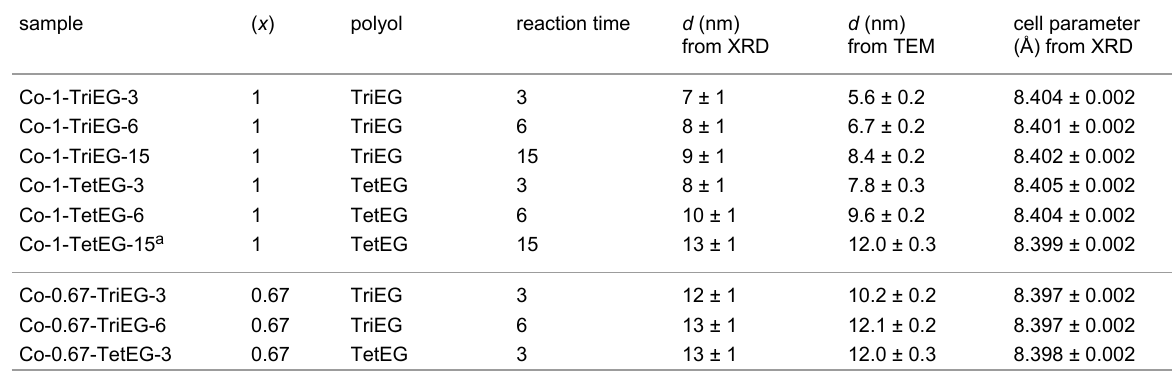
Table 1: Main structural features of the Co x Fe 3 − x O 4 nanoparticles, prepared by the polyol process.